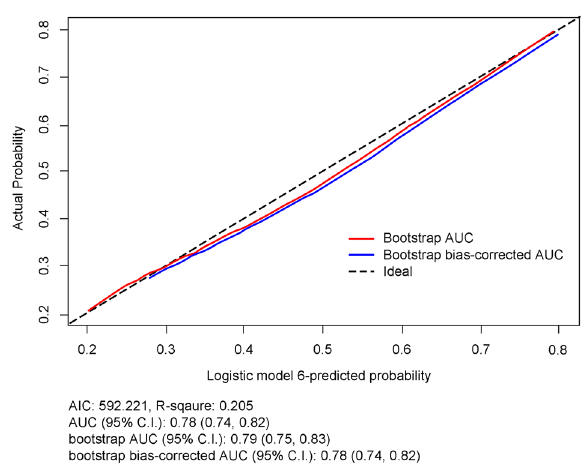
Fig. 2 Calibration curve to predict the histologic upgrade of logistic model 6. Notes: The x-axis represents the predicted upgrade risk. The y-axis represents the actual histologic upgrade. The diagonal dotted line represents a perfect prediction by an ideal model. The solid line represents the performance of model 6. The closer the solid line is to the diagonal, the more accurate the